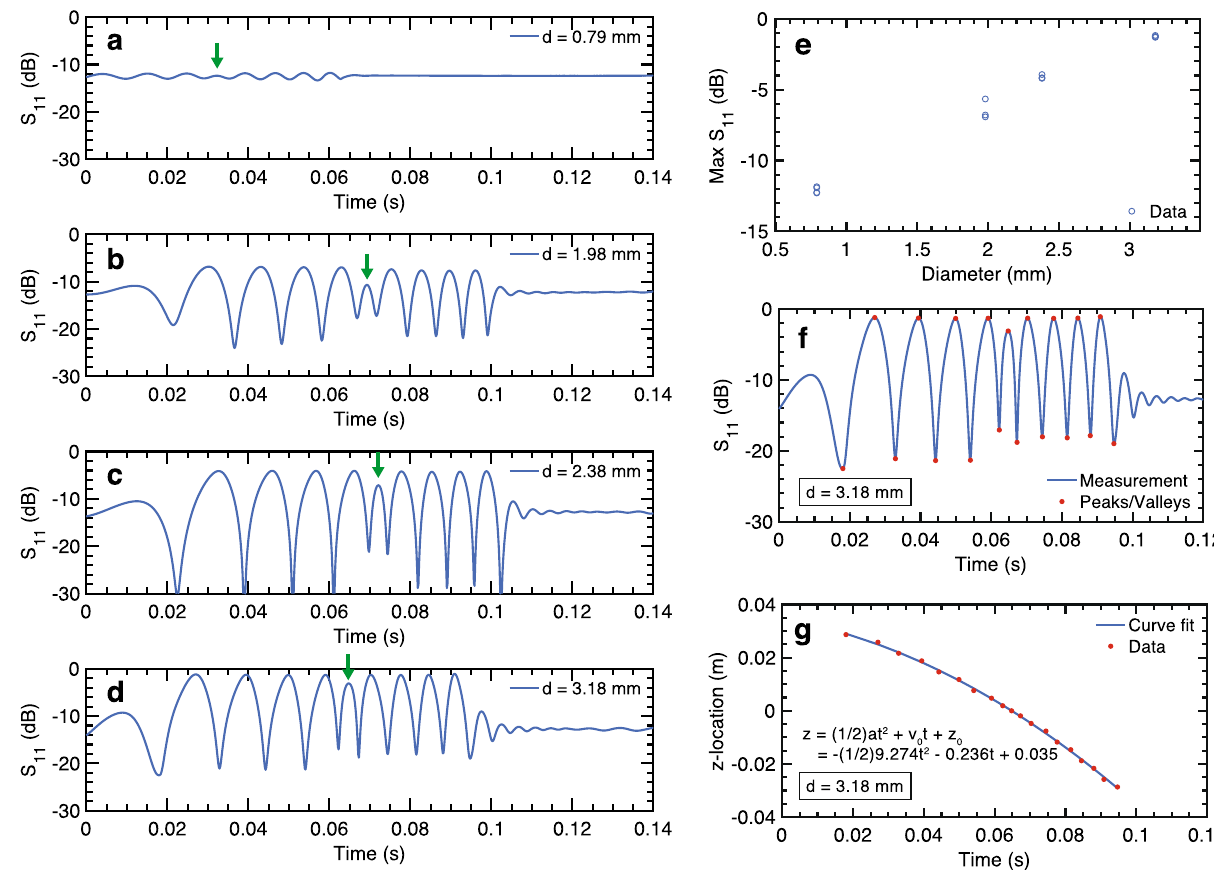
Figure 3. Solid metal sphere experiments. Time-domain S 11 measurement for aluminum spheres with diameters: ( a ) 0.79 mm, ( b ) 1.98 mm, ( c ) 2.38 mm, ( d ) 3.18 mm. The center lobe that marks the center of the T-junction is denoted by a green arrow. ( e ) Peak S 11 value (averaged over 8 peaks) for each sphere drop, as a function of sphere diameter. ( f ) Measured waveform for sphere with 3.18 mm diameter. Extrema are marked in red and can be associated with known positions in the T-junction. ( g ) The time stamps of extrema in ( f ) are plotted with position. A second-order polynomial curve fit is in Supplementary Fig. S3. The measured time-domain signals for each sphere are shown in Fig. 3a–d. The meas- ured S 11 signal variation exhibits the same features as those predicted by simulation for a spherical conductor in an open-ended T-junction (Fig. 2d). Four side lobes are observed for each time-domain S 11 waveform on each